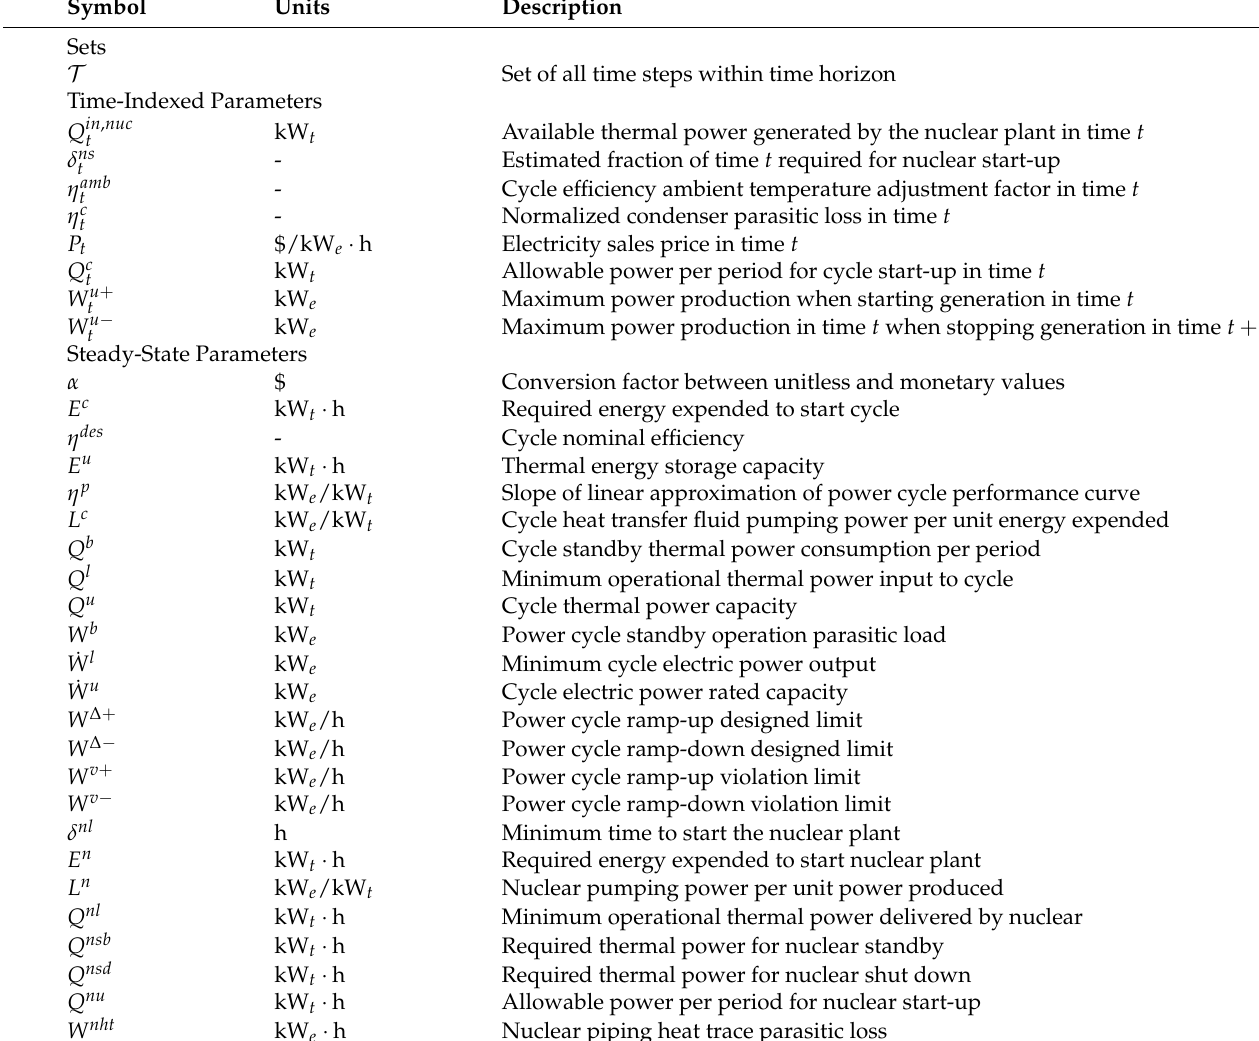
Table 2. Parameters used for dispatch